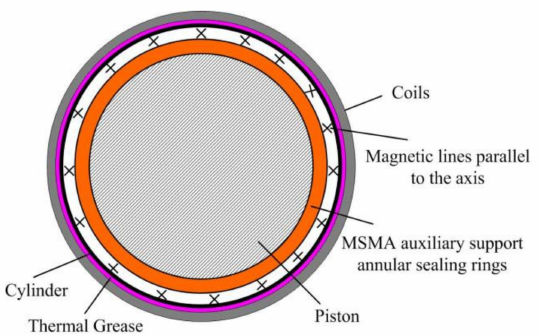
Figure 8. Schematic diagram of the excitation coil heat sink.